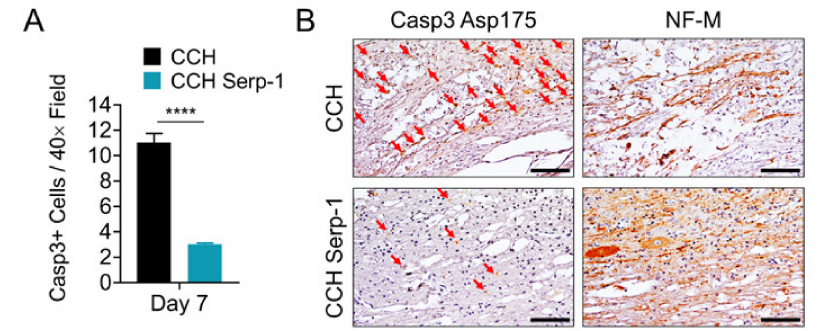
Figure 3. Serp-1 delivered by chitosan-collagen hydrogel reduces apoptosis in rat SCI. ( A ) Quantification of Casp3 + cells in areas defined as NF-M positive in serial spinal cord sections of rats post-SCI treated with 50 µ L chitosan-collagen hydrogel alone or 50 µ L chitosan-collagen hydrogel with 100 µ g Serp-1 at days 7 after injury. Mean and standard error are presented. Statistics performed by T-test where **** p < 0.0001. ( B ) Representative immunohistochemical staining (brown) of cleaved, active Casp3 (Asp175) and NF-M in serial sections of the same conditions quantified in panel A. Red arrows indicate cells positive for active Casp3. Scale bars are 50 µ